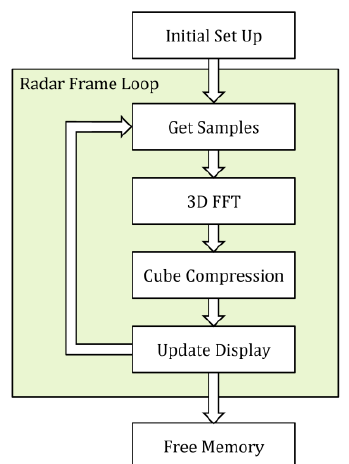
Fig. 2. Radar Frame Computations Steps using 3D FFT method